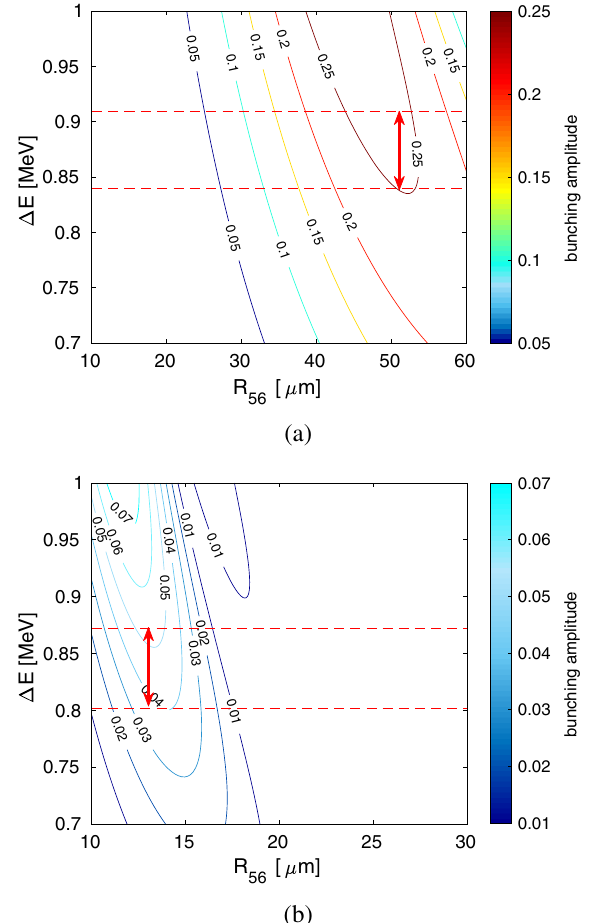
FIG. 8. Analytically calculated bunching maps [see Eq. (4)]. The red horizontal dashed lines show the peak to peak fluctua- tions calculated for 100 passes in the oscillator and the red double arrow indicates the bunching fluctuations for the R 56 used in the simulations. (a) 5th harmonic of 300 nm. (b) 12th harmonic of 50